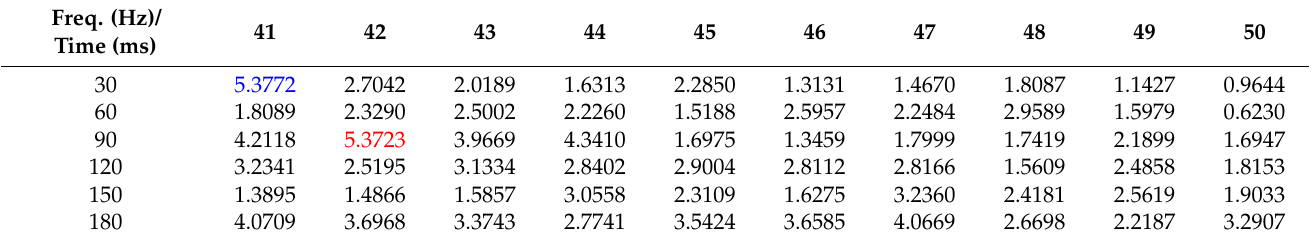
Figure 8. Hilbert Spectrum, time–frequency–energy distribution, ( a ) HS1 of class I, ( b ) HS1 of class II, ( c ) HS2 of class I, and ( d ) HS2 of class II. Table 6. The data of HS1 of class I, main frequency band 41–50 Hz, sampling time interval 30 ms. The maximum and second-highest energy ratios are highlighted in red and blue, respectively.